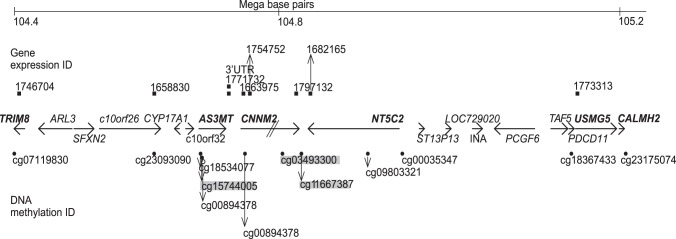
Map of genes in chromosome band 10q24 associated with AS3MT haplotype-related DNA methylation.Positions of DNA methylation and gene expression assays are also shown. Black circles denote DNA methylation sites statistically significantly associated with AS3MT haplotype in Argentina and the white circle denotes the DNA methylation site statistically significantly associated with AS3MT haplotype in Bangladesh. A grey box around the DNA methylation ID denotes DNA methylation sites statistically significantly associated with AS3MT haplotype in both Argentina and Bangladesh.